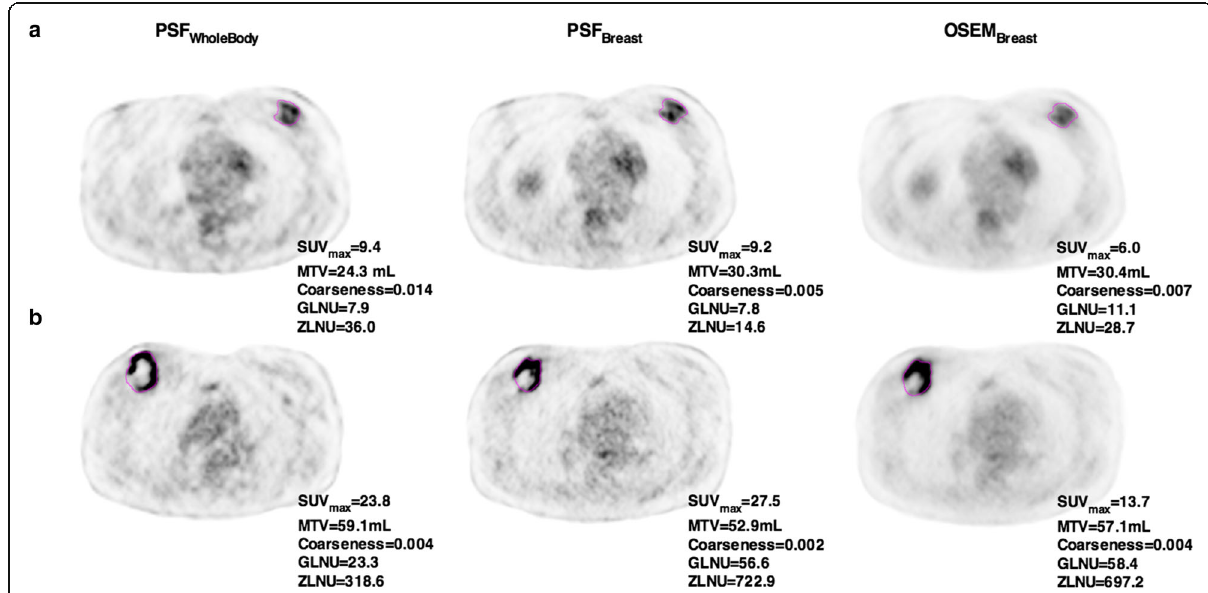
Fig. 6 Representative images of one luminal ( a ) and one non-luminal ( b ) breast tumour. The luminal tumour was a luminal B HER2 negative T3N1M0 ductal carcinoma. The non-luminal tumour was a T2N1M0 triple-negative ductal carcinoma. Images were scaled on the same maximum value (SUV =